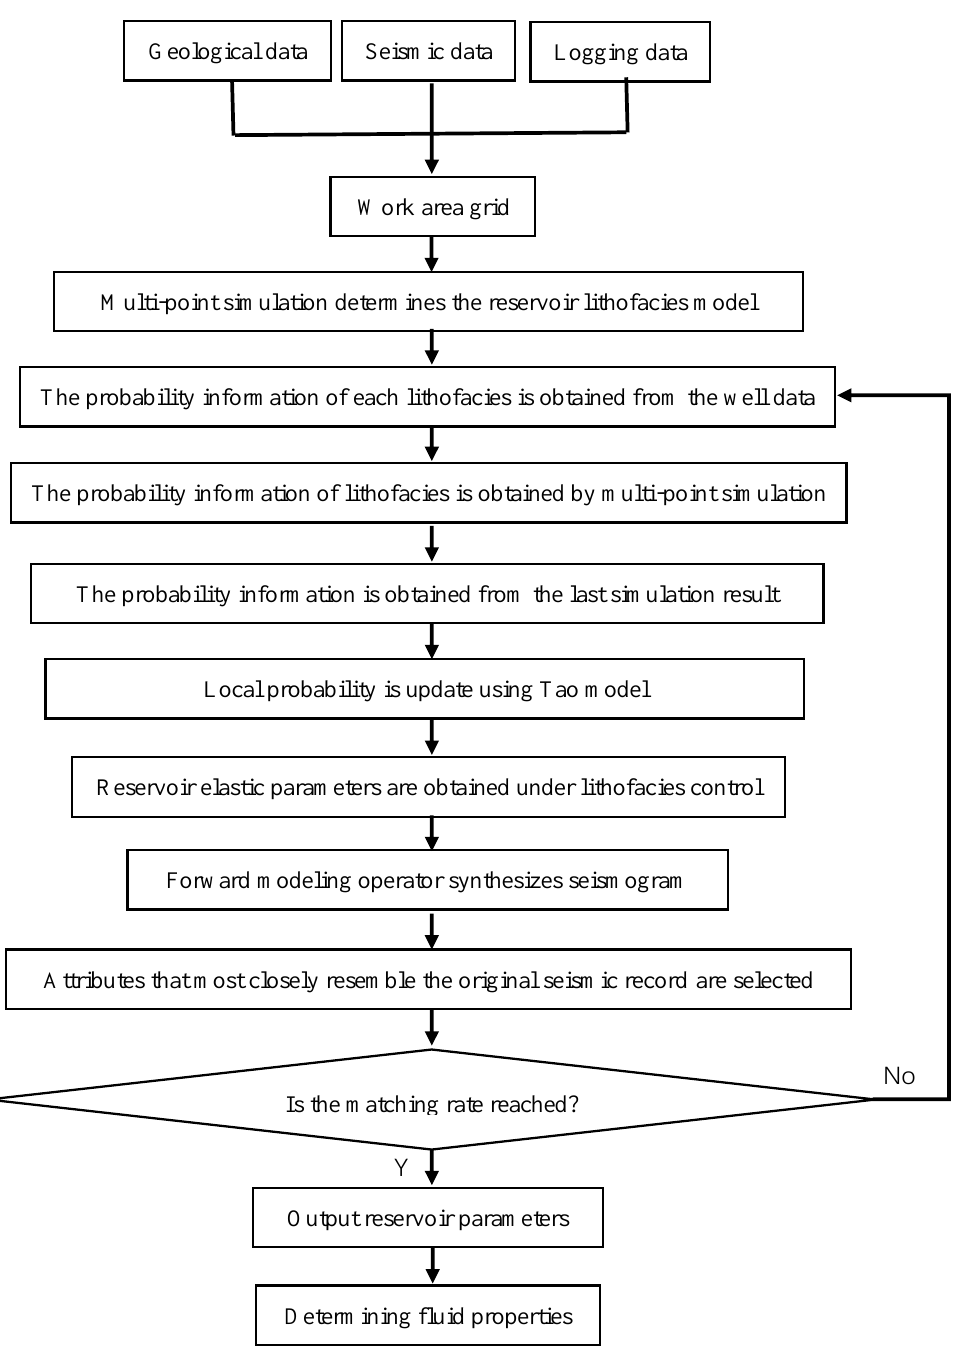
Figure 1. New multi-point geostatistical inversion flow chart considering local updating.